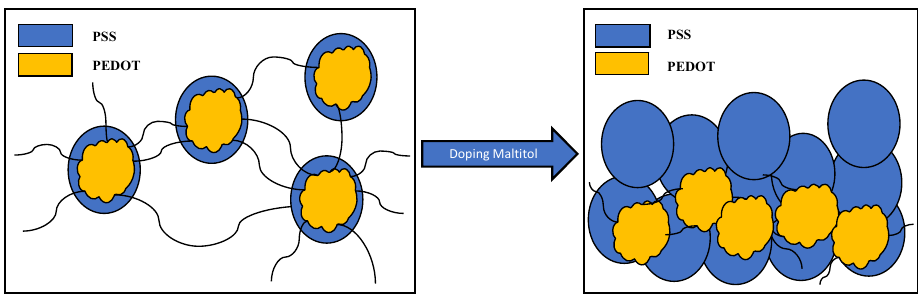
Figure 6. A schematic of maltitol added to PEDOT: PSS, presenting phase separation between PEDOT and PSS.